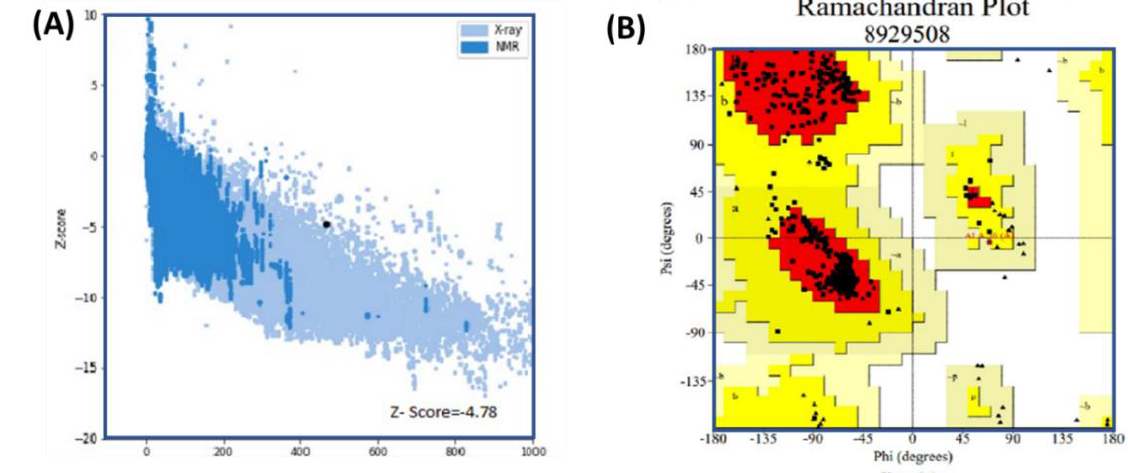
Figure 5. Results of analysis using the Ramachandran and PROSA-web servers. Panel ( A ) shows the Z-score (4.78) predicted by PROSA-web. In panel ( B ), the Ramachandran plot shows the amino acid distribution in the favored, allowed, and disallowed regions. Favored regions are reported with 91.8% residence, with 7.9% allowed and 0.3% reported as being disallowed.